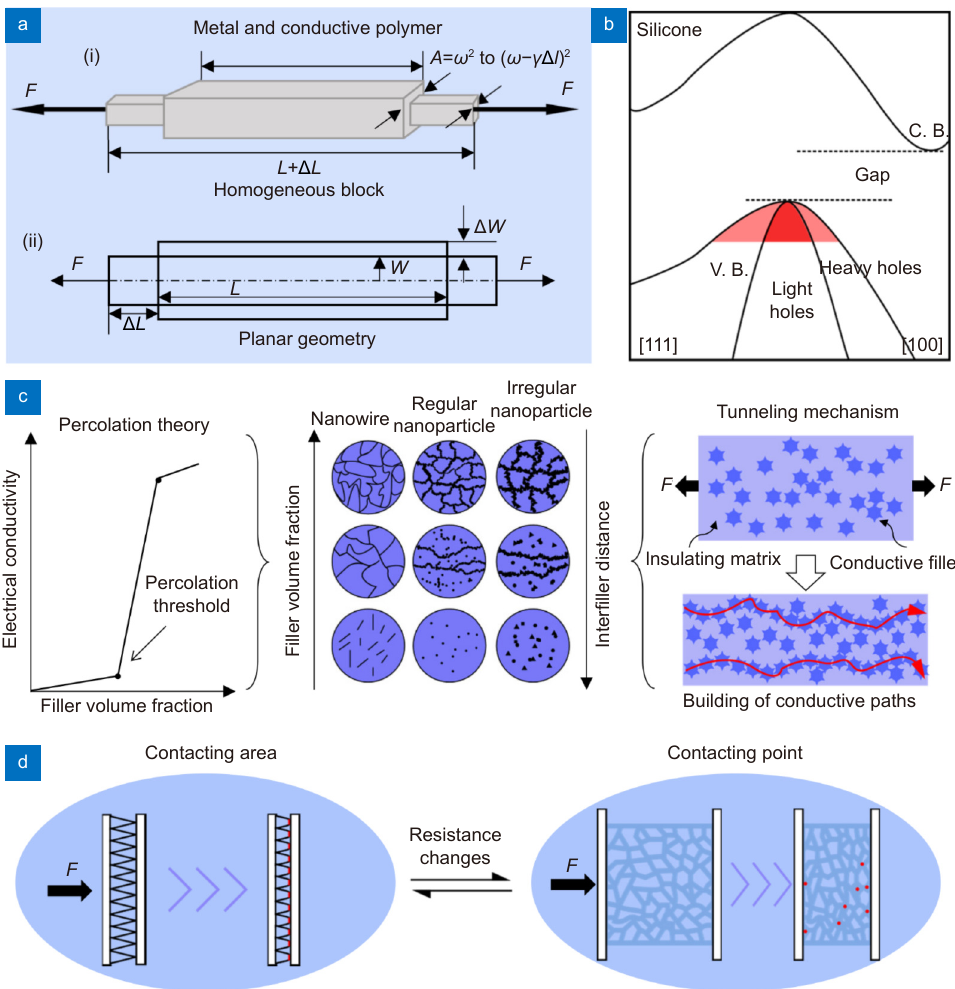
Fig. 2 | Principles of piezoresistive effect. ( a ) Piezoresistance based on the geometric changes of metals and conducting polymers. i and ii represent the block and planar material geometries, respectively 41,47 . ( b ) Piezoresistance of semiconductor. Scheme illustrating the changes of charge carrier and energy band upon traction along the [111] direction in p–Si 47 . ( c ) Piezoresistance of composite materials based on the changes of conducting filler concentration and inter-filler distance 48 . ( d ) Structural piezoresistance based on the contact area and point changes of conducting architecture. Figure reproduced with permission from: (b) ref. 47 ,